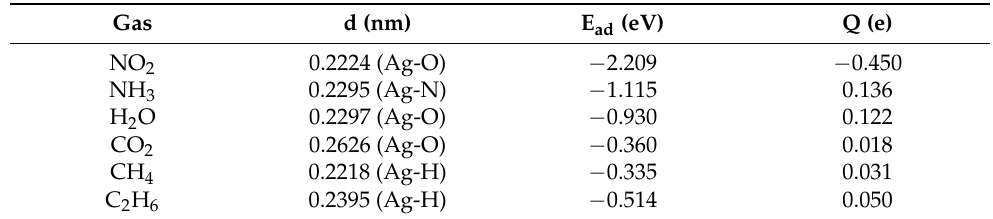
Table 2. Adsorption distance, adsorption energy, and Mulliken charge of different gas molecules on Ag-doped